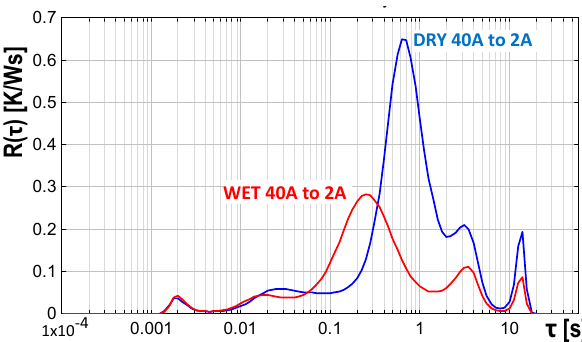
Figure 9. Time constant spectrum calculated from the Z th curve of Figure 7 .